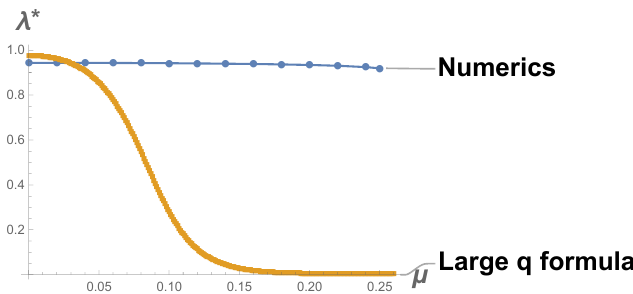
Figure 10. Numerical results for the Lyapunov exponent for q = 4 interaction as against analytical results for large q